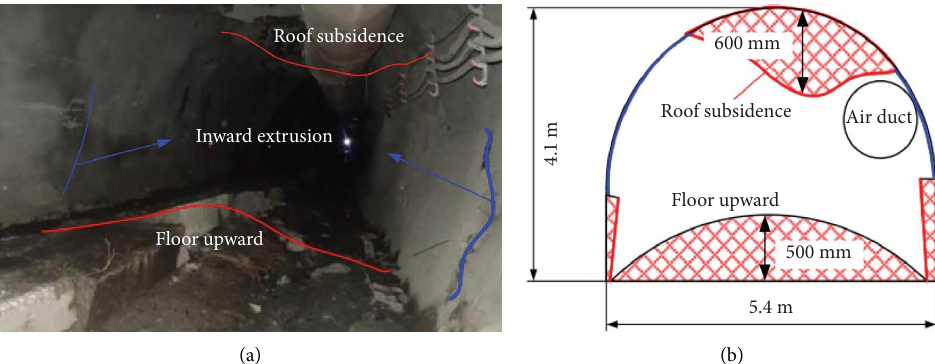
Figure 3: Schematic diagram of weak cemented roadway damage. (a) Roadway failure diagram and (b) sketch of roadway